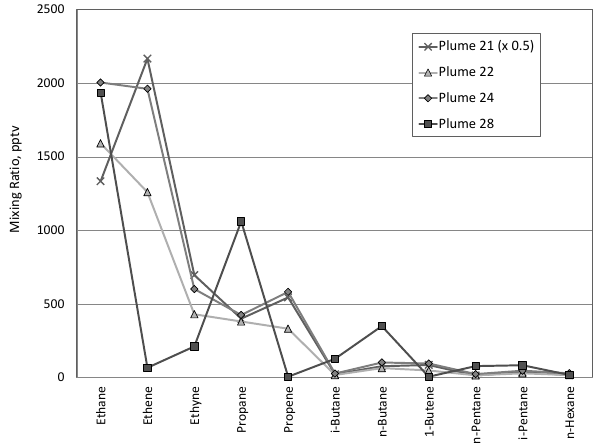
Fig. 6. Average hydrocarbon mixing ratios observed in four differ- ent Canadian BB plumes indicating differences in relative propor- tions of saturated and unsaturated